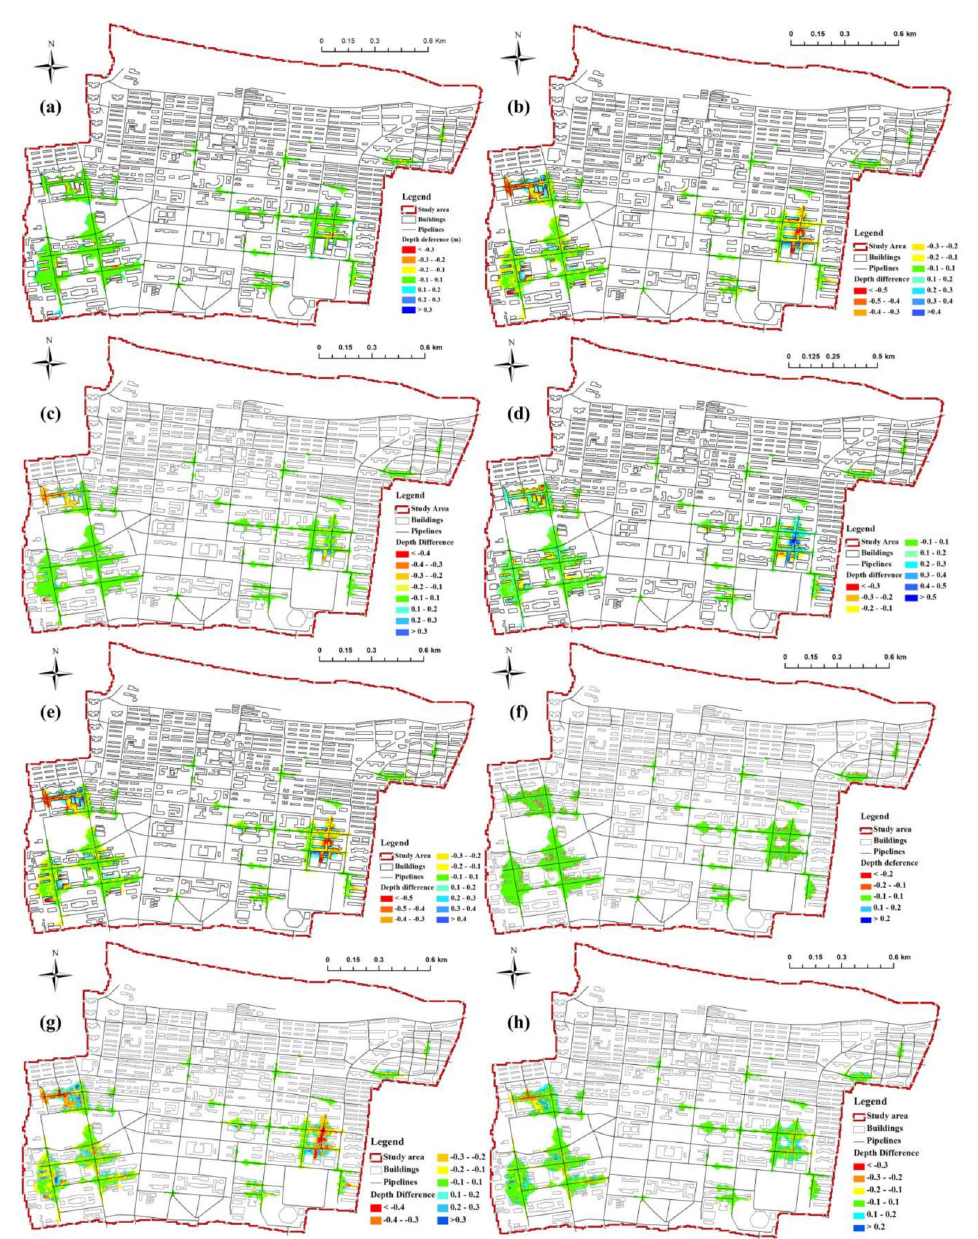
Figure 14. Differences in maximum inundation extent and inundation depth between two paired modeling scenarios: ( a ) BB-BH Methods; ( b ) IBTA0.4-BB methods; ( c ) IBTA0.6-BB methods; ( d ) IBTA0.6-IBTA0.4 methods; ( e ) IBTA0.4R-BB methods; ( f ) IBTA0.4R-IBTA0.4 methods; ( g ) BR-IBTA0.6 methods; and ( h ) BR-IBTA0.4R